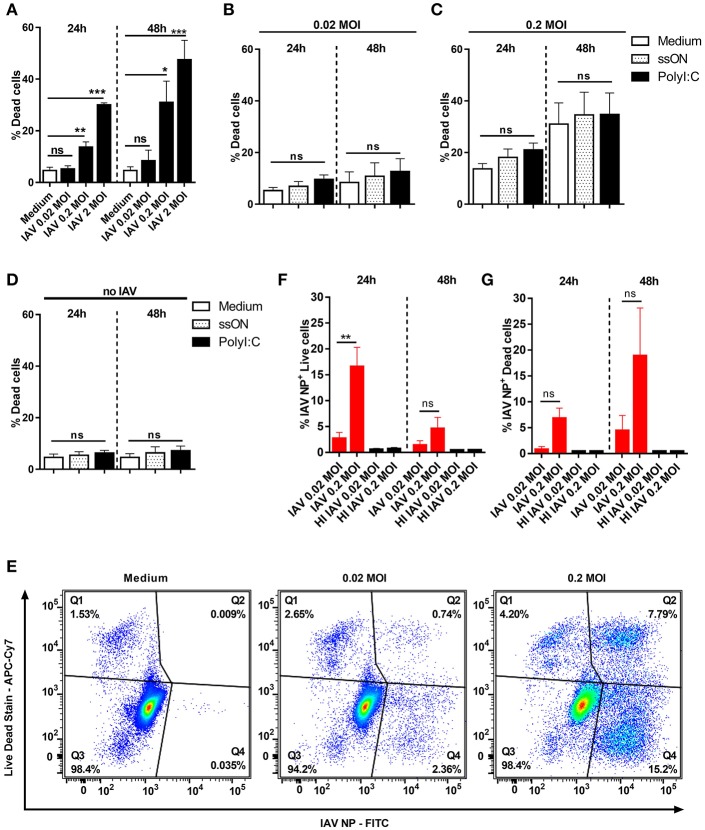
Cell death in IAV-infected and non-infected MoDC. MoDC were mock or IAV-infected at indicated MOI for 4 h and the viability was measured by flow cytometry after culture in medium or stimulation with ssON or PolyI:C. (A–D) The frequency of dead MoDC was measured 24 and 48 h p.i. by flow cytometry. Graphs represent mean ± SEM with n = 8–12 (24 h) and n = 5–8 (48 h) except for MOI of 2 (n = 2 in triplicates for both time points). In (A), statistical comparisons were made between mock infection (“Medium”) and IAV infections. In (B–D), the different treatments with ligands were compared with IAV infection without any ligands (white bars). Statistics were calculated using Kruskal-Wallis one-way ANOVA test with Dunns multiple comparisons test and alpha set to 0.05. (E) Representative flow cytometry plots showing the gating strategy to determine dead non-infected (Q1), dead IAV-infected NP+ (Q2), live non-infected (Q3), and live IAV−infected NP+ (Q4) MoDC. (F,G) Bar graphs showing percentages of live (F) and dead (G) IAV-infected NP+ MoDC over time (red bars). Mean ±SEM with n = 9 for 24 h and n = 5 for 48 h except for the control HI IAV (HI 0.02, n = 3 and 1, HI 0.2, n = 4 and 2, 24, and 48 h respectively). P-value: not significant (ns) P > 0.05; *P ≤ 0.05; **P ≤ 0.01; ***P ≤ 0.001.